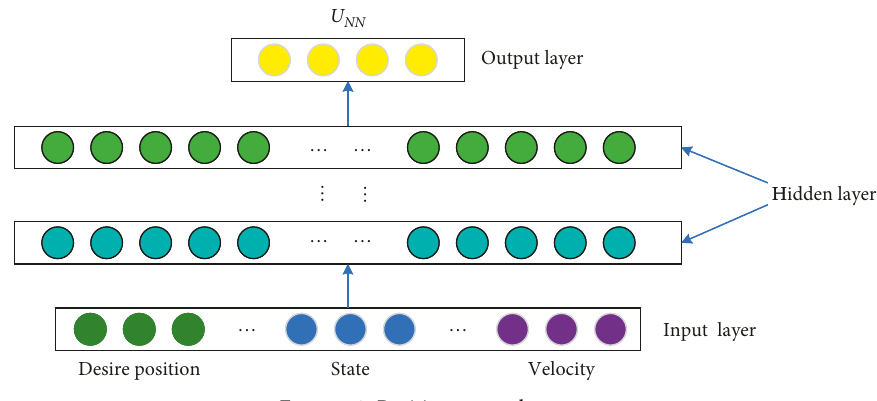
Figure 4: Position control